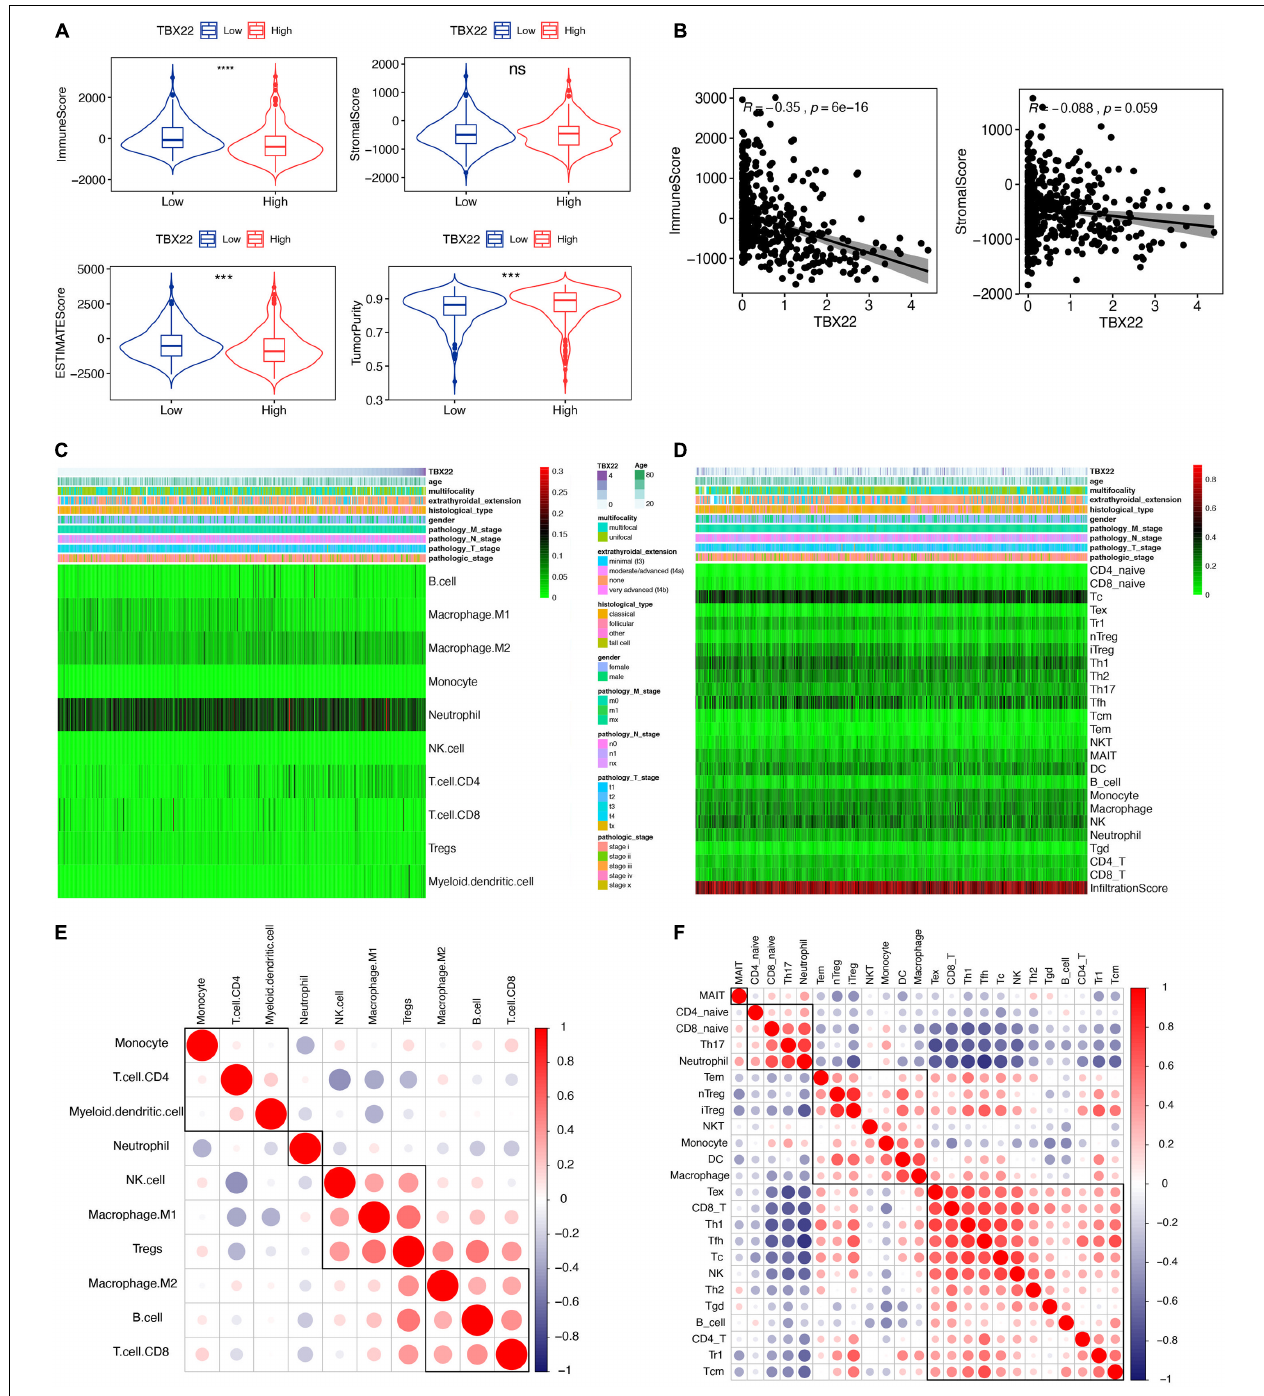
FIGURE 6 | TBX22 is related to tumor immune microenvironment phenotype. (A) Comparison of the immune score, stromal score, microenvironment score, and tumor purity between the TBX22 high and TBX22 low groups. The p -value, testing the group difference, was calculated with the two-sided Wilcoxon rank-sum test. (B) Spearman correlations between TBX22 expression and immune and stromal scores. (C,D) Heatmap of the TIIC proportions in the PTC microenvironment quantified by (C) quanTIseq and (D) ImmuCellAI. (E,F) Spearman correlation matrix of the different TIIC proportions in the PTC microenvironment quantified by (E) quanTIseq and (F) ImmuCellAI. *** p < 0.001, **** p < 0.0001.